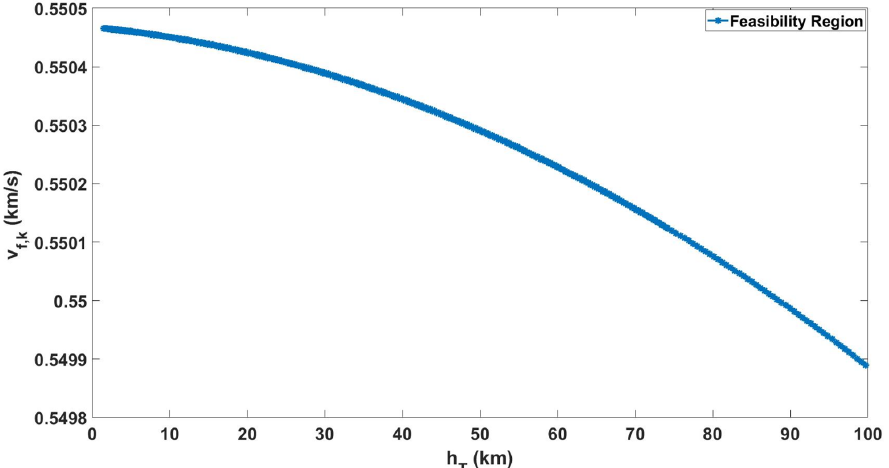
Figure 19. Relative velocities of the spacecraft with respect to Phobos inside the feasible